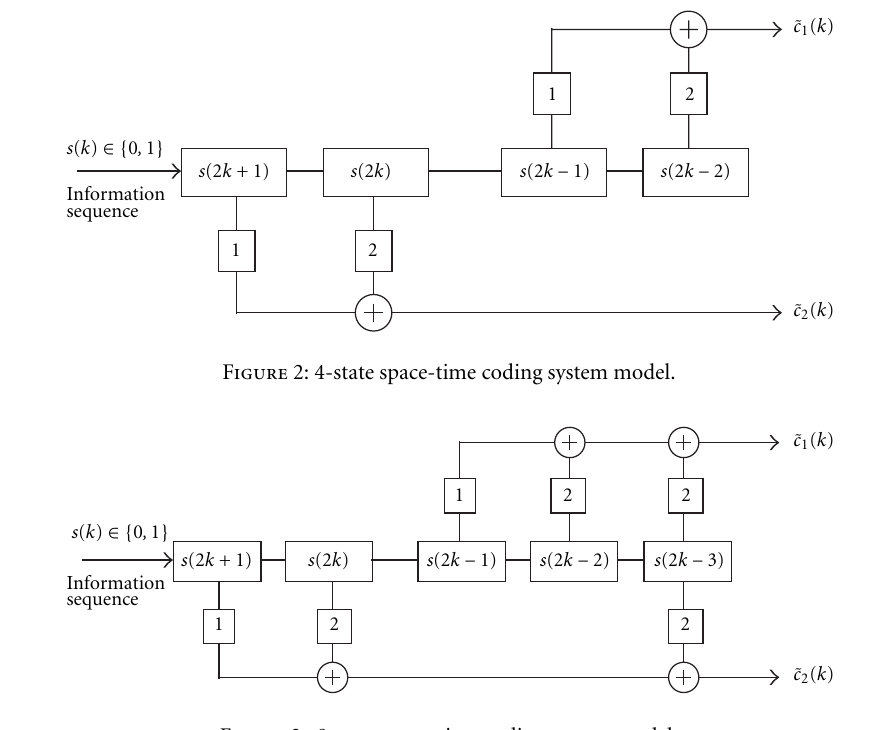
Figure 3: 8-state space-time coding system